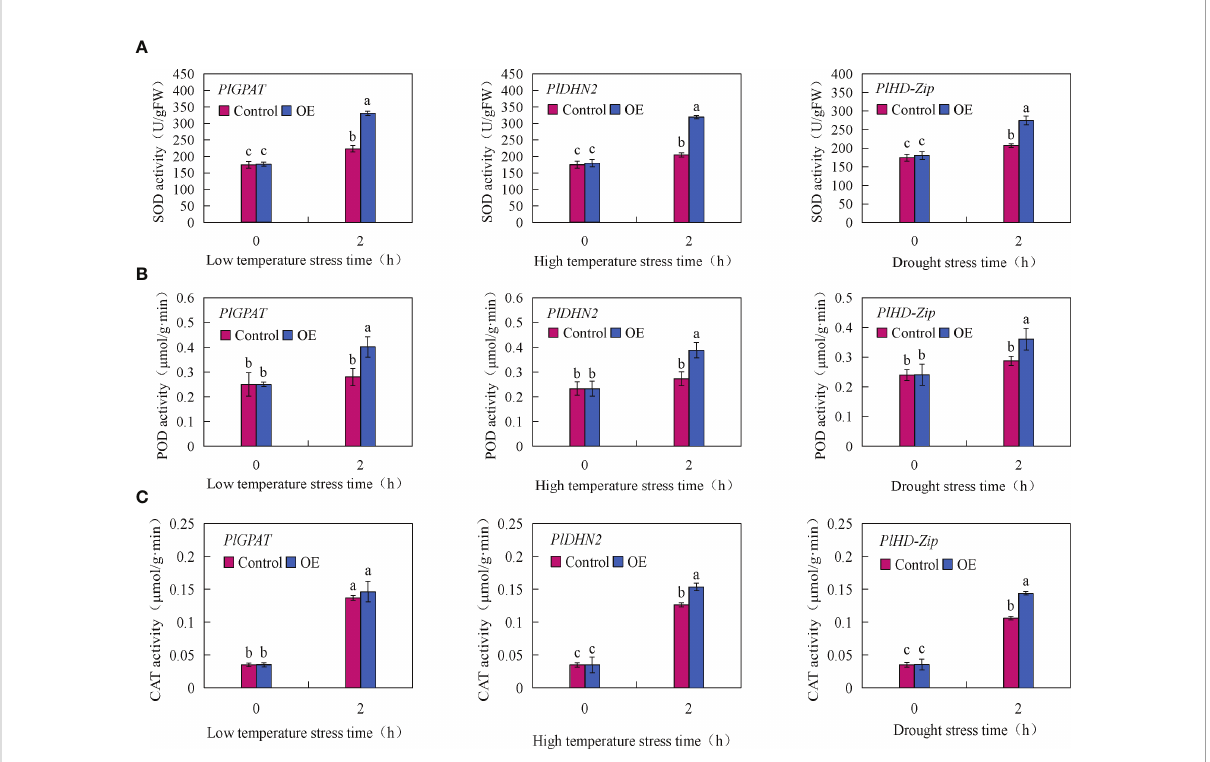
FIGURE 7 Analysis of antioxidant enzyme activity in P. lacti fl ora seedlings with transient overexpression of stress resistance genes. (A) SOD activity. (B) POD activity. (C) CAT activity. Error bars indicate standard deviation of three replicates. Different letters mean signi fi cantly different by Duncan ’ s multiple range test at P <